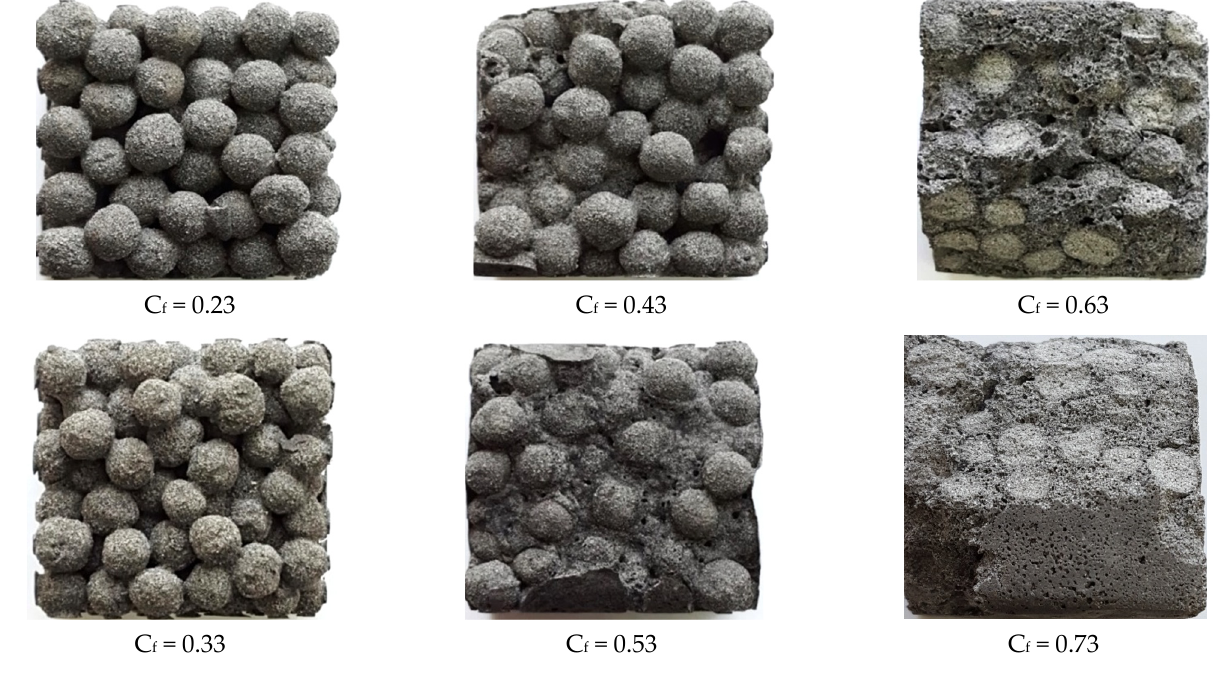
Figure 12. The structure of liquid glass composite materials with different ratio “binder volume: filler volume”.